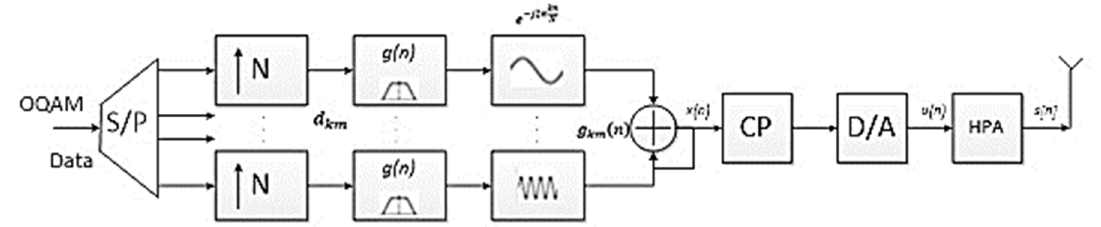
Figure 1. Generalized frequency division multiplexing (GFDM) system with high power amplifier (HPA).